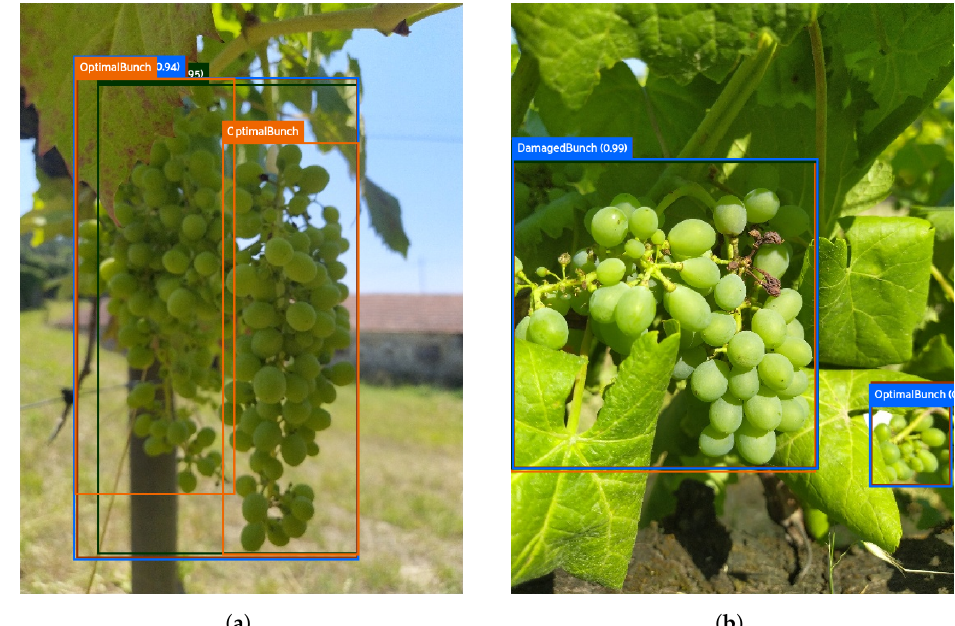
Figure 9. FPs in samples from the test set coincide across datasets. Orange bounding boxes present ground truth. Red bounding boxes present the predictions from YOLOv5. Green bounding boxes present the predictions from YOLOv7. Blue bounding boxes present the predictions from YOLOR. ( a ) Example 1. ( b ) Example 2.